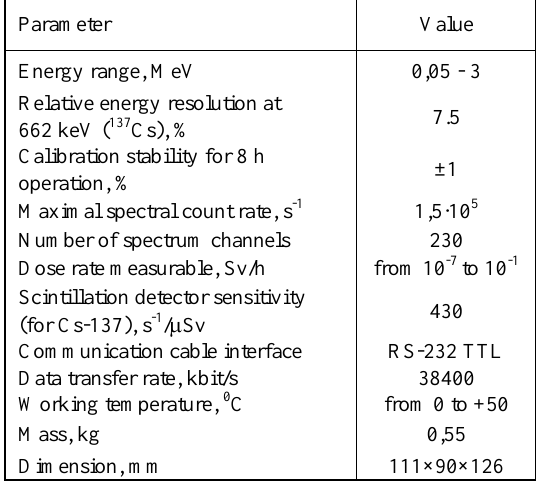
Table 1. RSD technical parameters